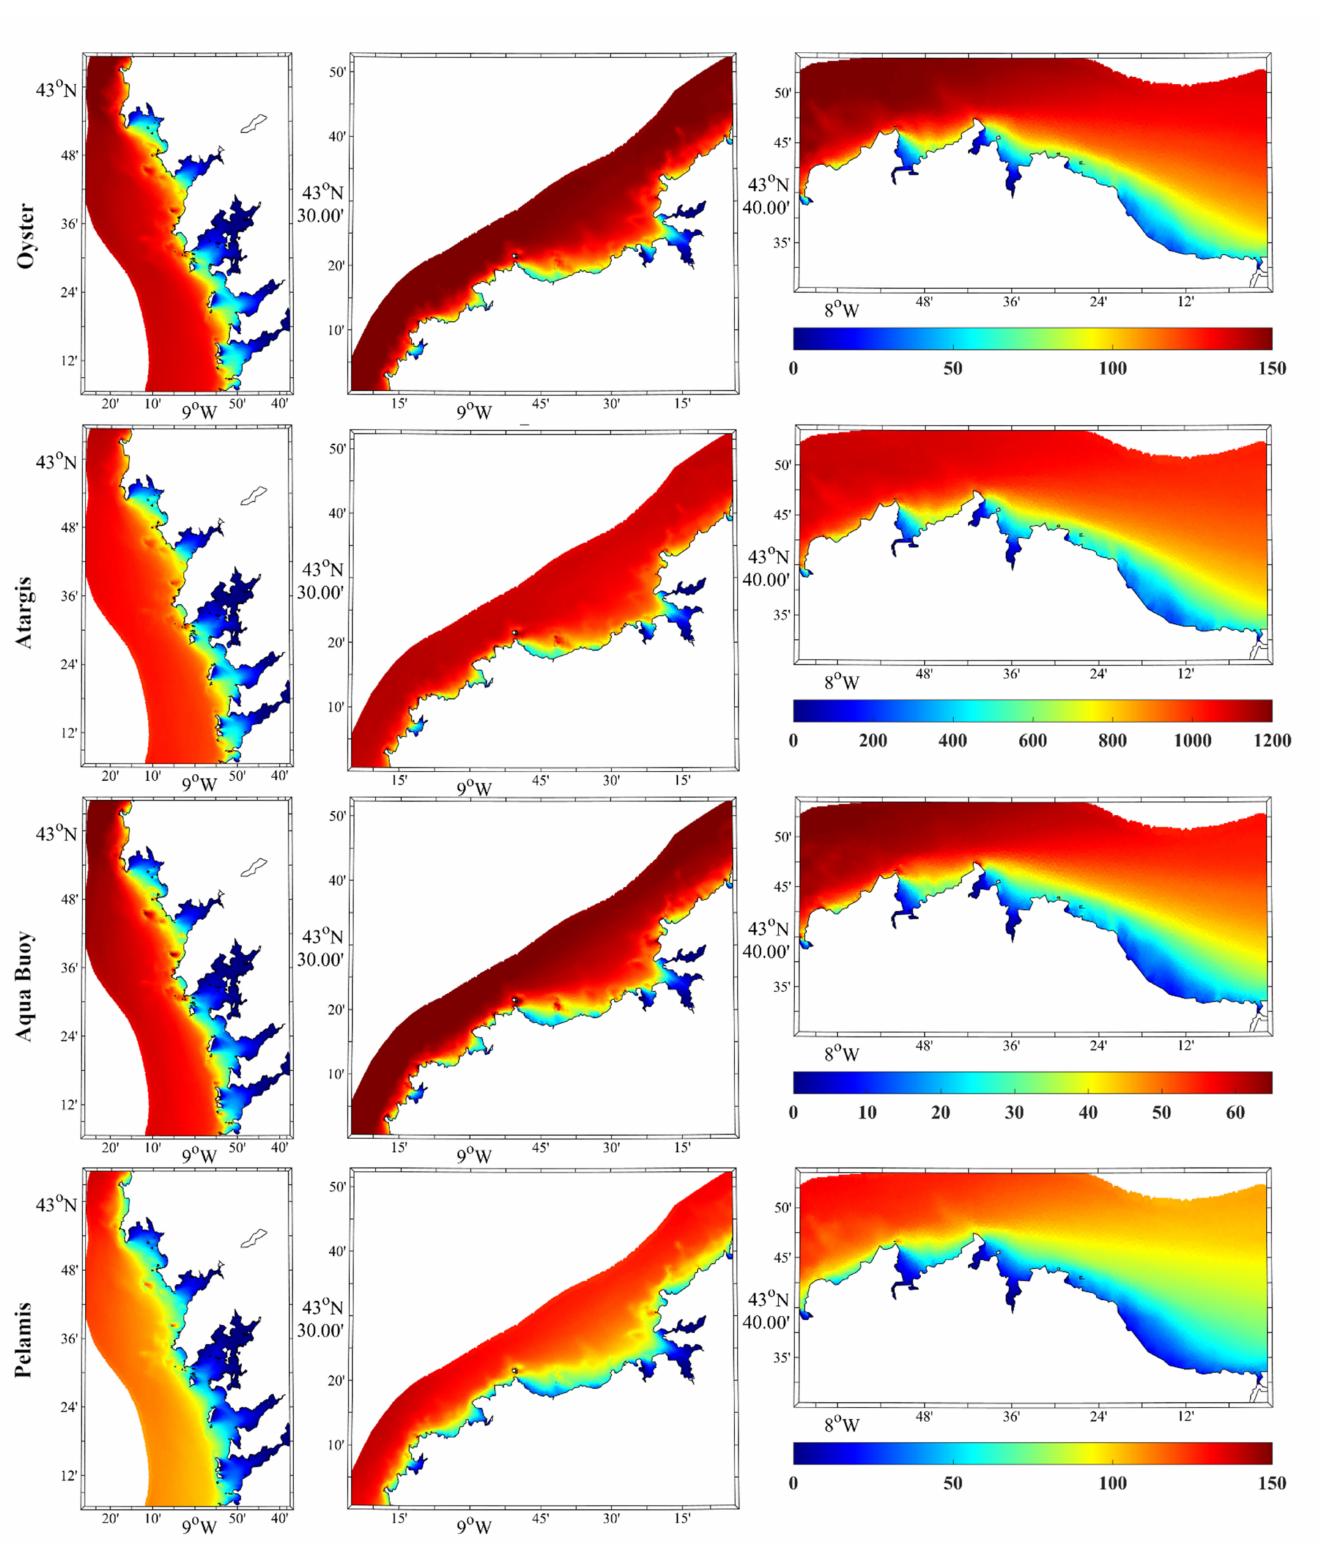
Figure 4. Electric power capacity (P E , in kW) of the Oyster, Atargis, Aqua Buoy, and Pelamis devices for the West Coast ( left column), the Northwest Coast ( middle column), and the North Coast ( right column) for the period